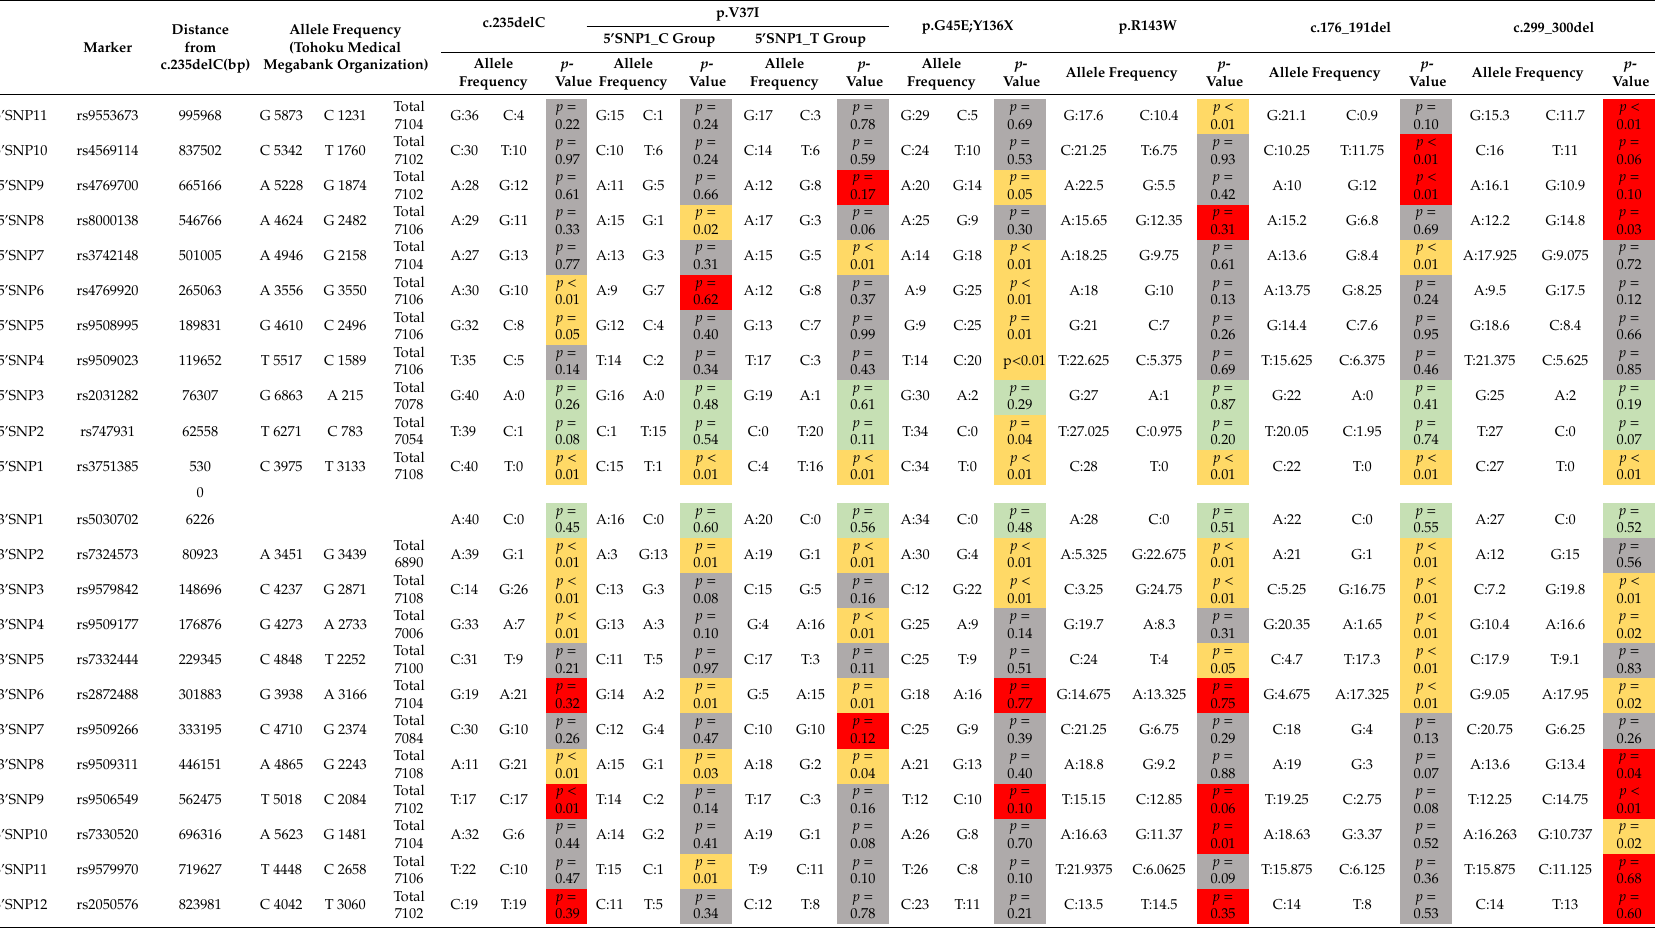
Table 1. Results of the haplotype analysis for six frequently observed GJB2 mutations in the Japanese